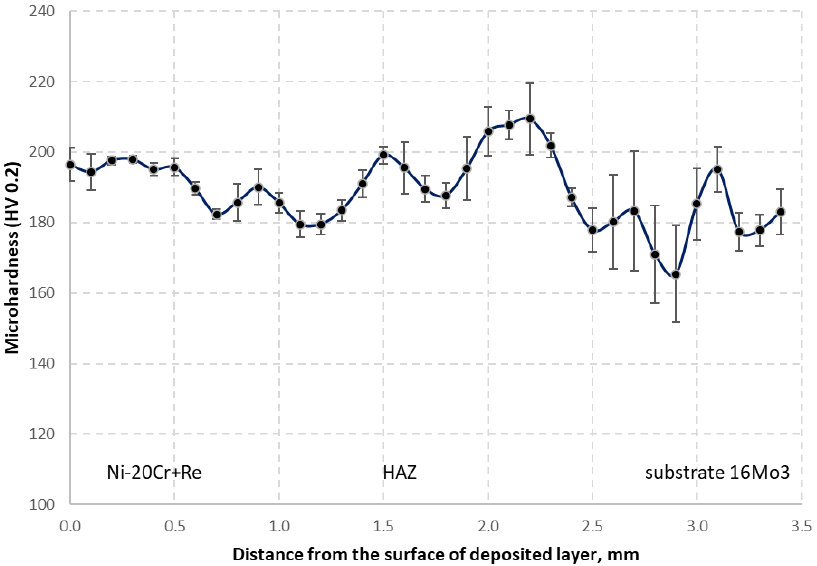
Figure 21. Microhardness distribution at the cross-sections of the deposited multi-bead Ni-20Cr+Re layer produced with 2400 W laser